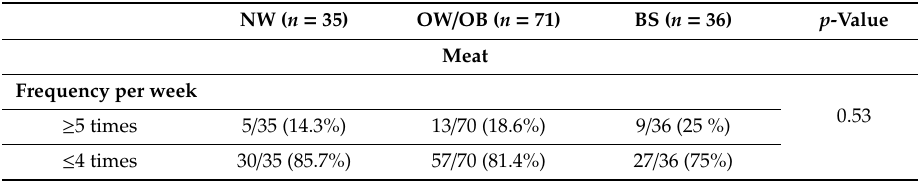
Table 4. Consumption of the main food groups by the